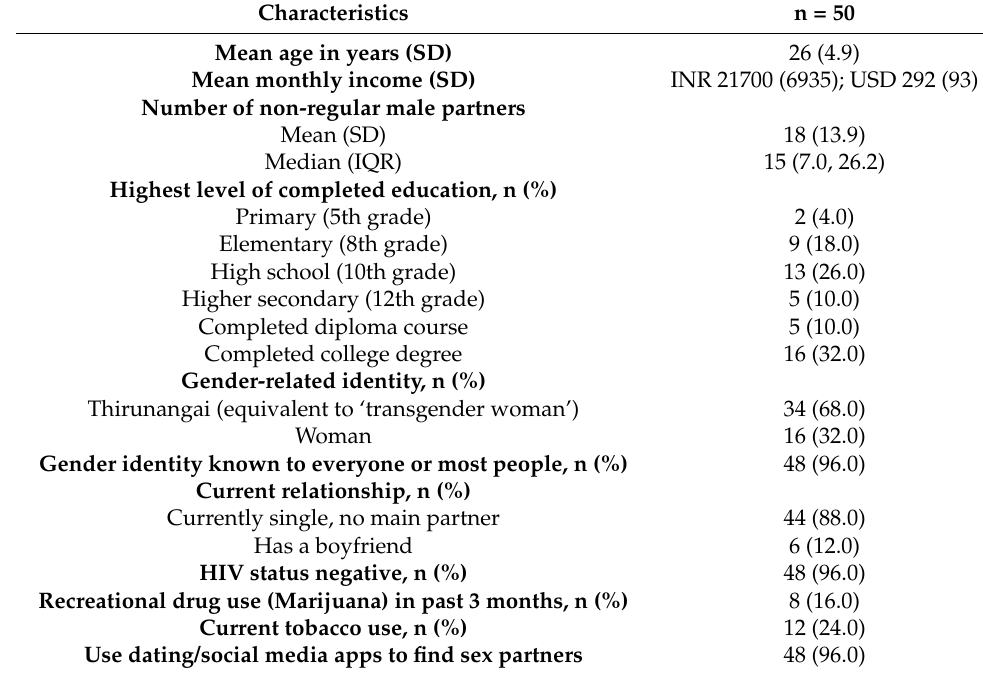
Table 3. Baseline characteristics of transgender women enrolled in Sakhi , a 3-Week pilot smartphone- based HIV prevention intervention (n =